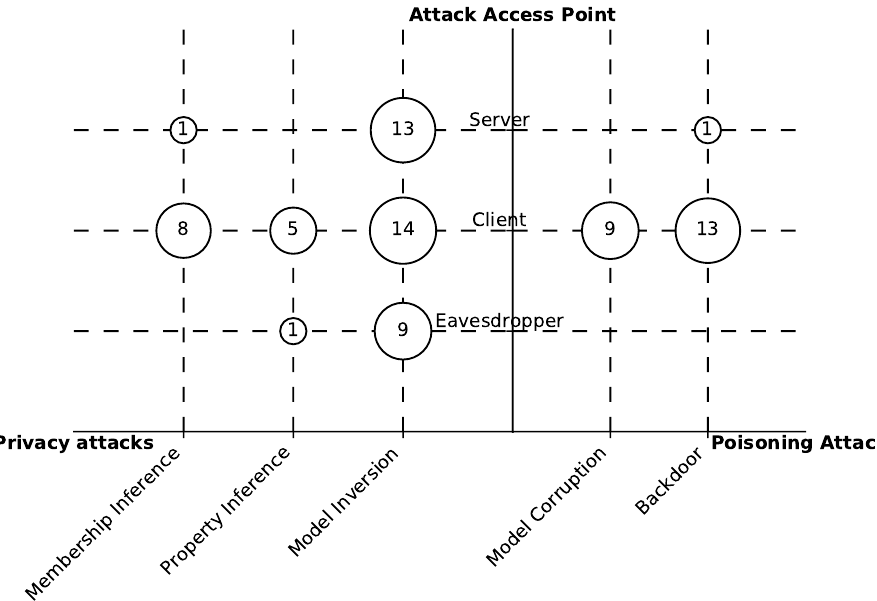
Figure 10. Bubble chart that shows the papers’ distribution on two dimensions: attack purpose and access point. Aside from model inversion, we notice a low number of attacks for the server and eavesdropper access